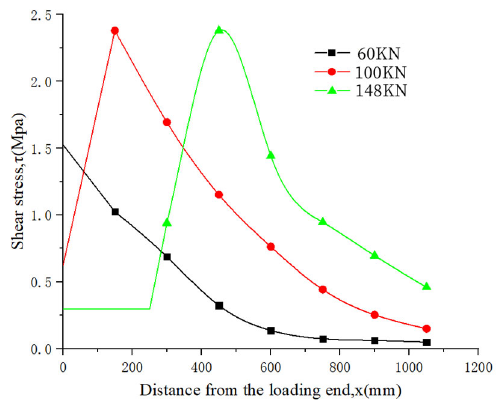
Figure 7. Shear stress distribution law of measuring point at the anchorage agent interface.